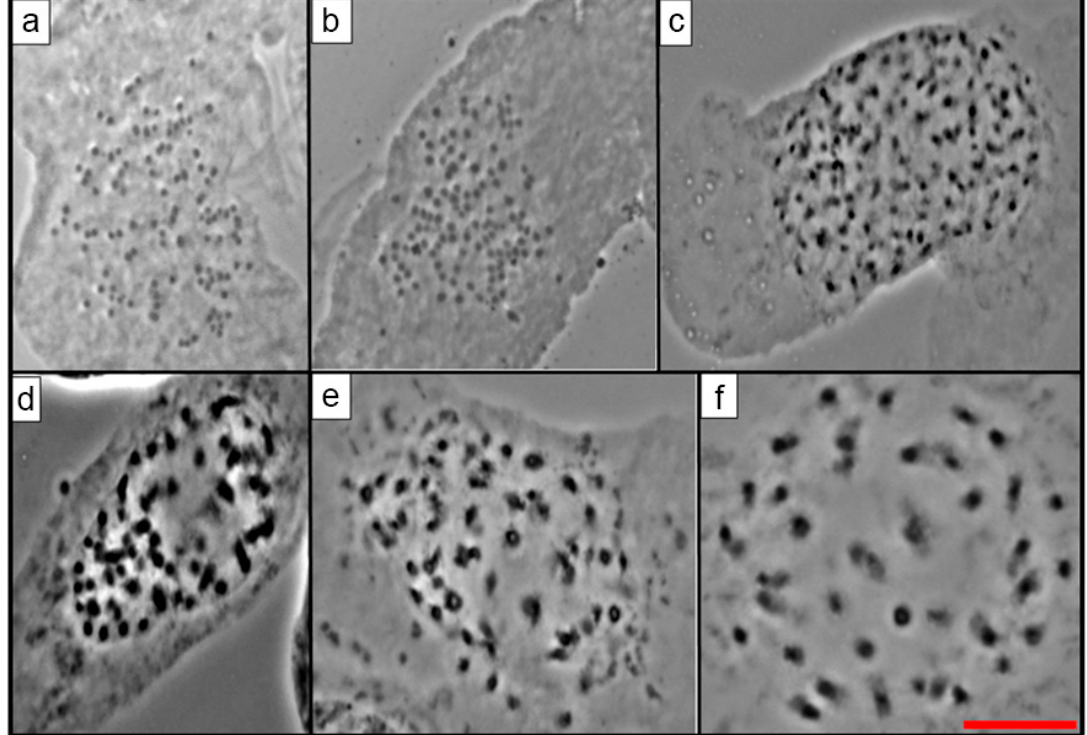
Figure 2. ( a ) E. cupreata 2 n = 108, ( b ) E. dactylifera 2 n = 108, ( c ) E. gibbiflora 2 n = 172, ( d ) E. guerrerensis 2 n = 54 (Accession number JE-7521), ( e ) E . guerrerensis 2 n = 54 (Accession number JE-7526), ( f ) E. helmutiana 2 n = 42. Scale equals 10 µm.